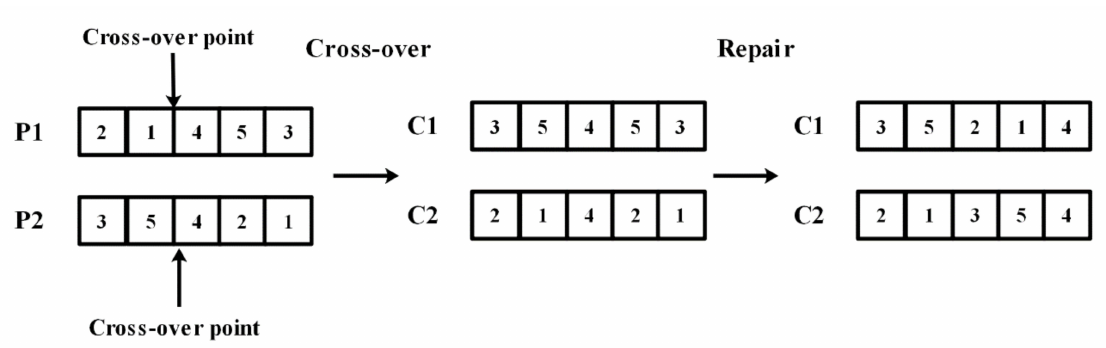
Figure 3. Schematic of a